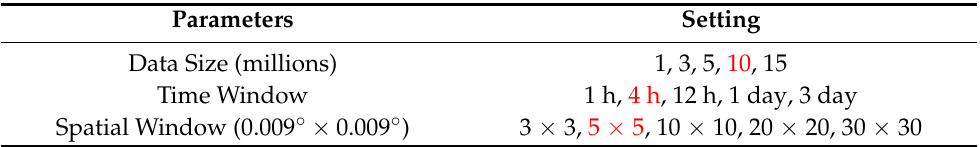
Table 2. Query settings (the red font is the default value).